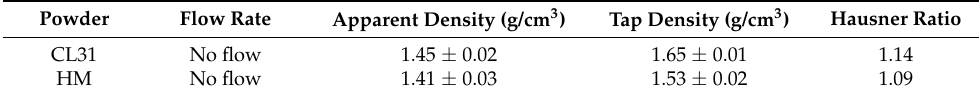
Table 4. Flowability values of the